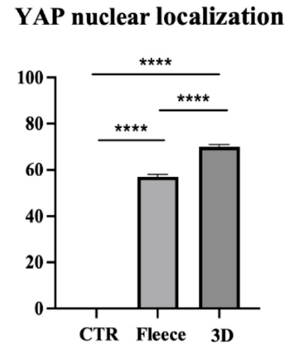
Figure 12. Percentage of YAP nuclear localization after seeding on Petri dishes (CTR), PLGA fleeces and 3D scaffolds. **** Significant difference between the different groups ( p < 0.0001).